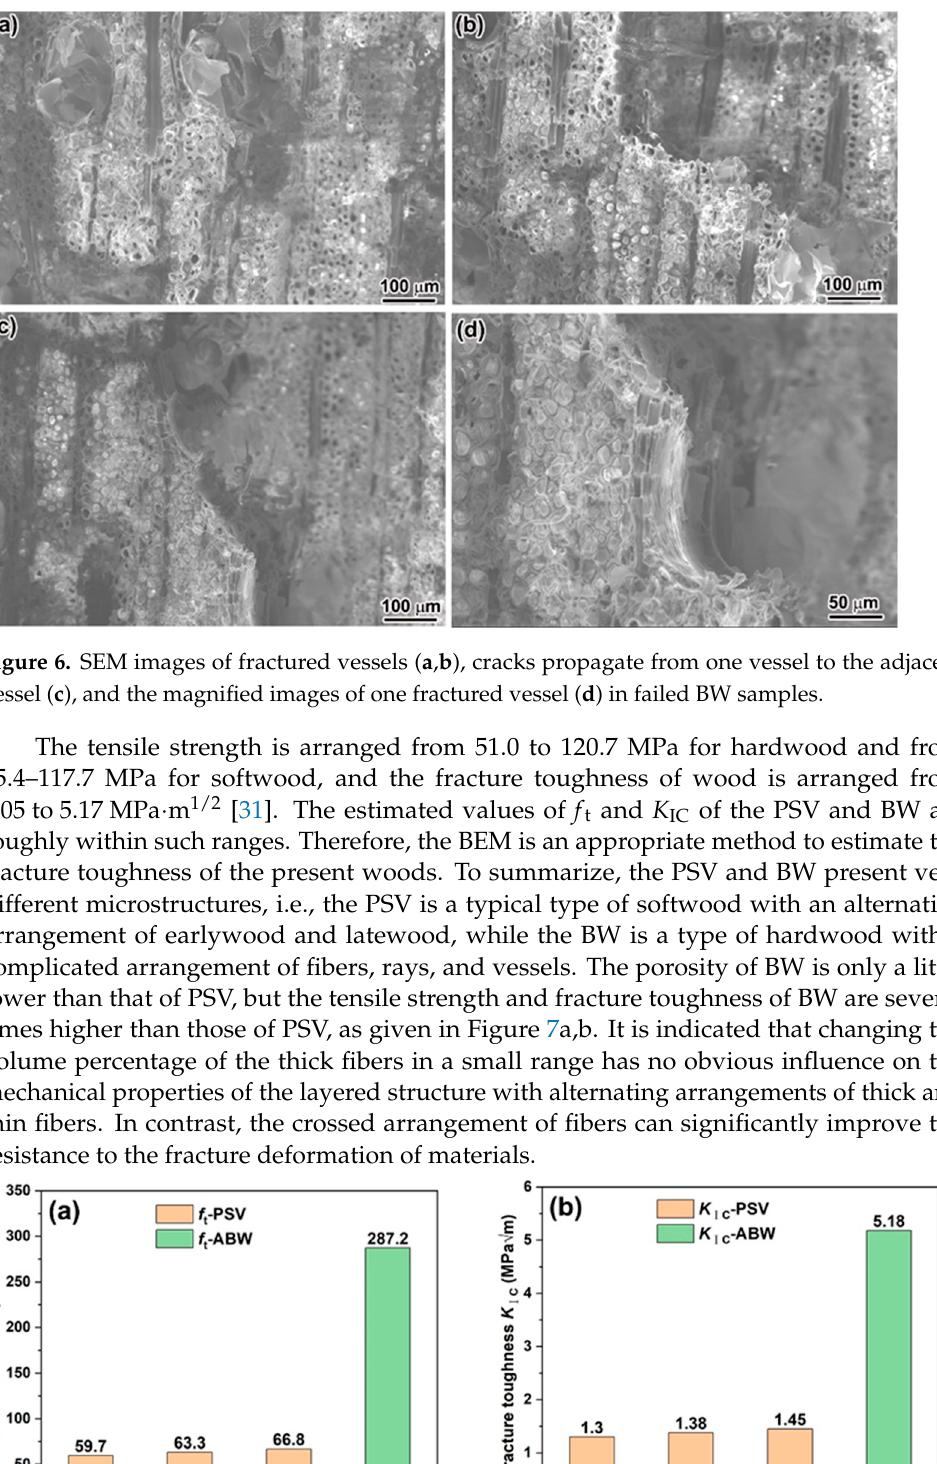
Figure 5. ( a – c ) Side views of the failed samples, and the normal distribution of the tensile strength ( d ) and fracture toughness ( e ) of BW.